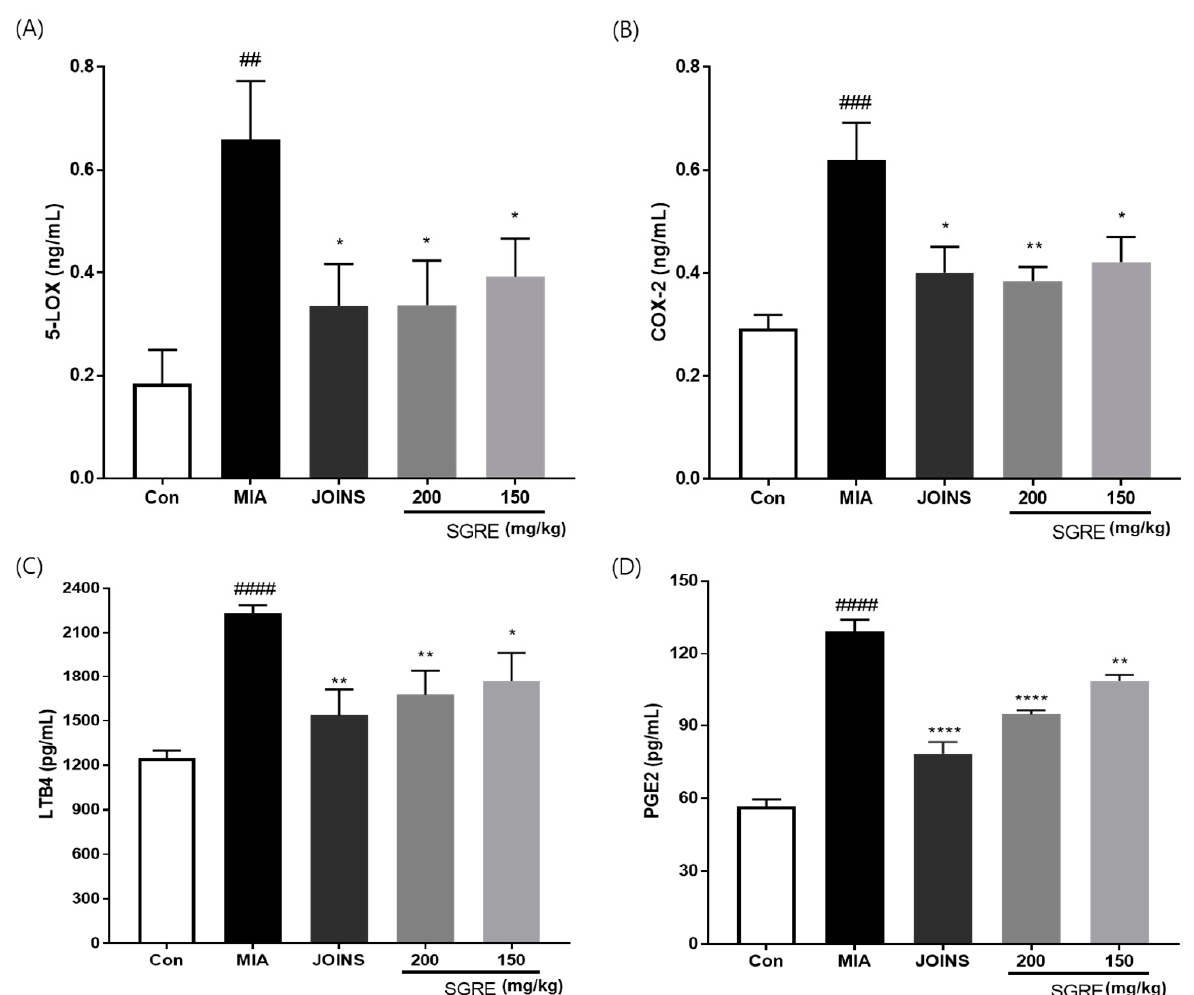
Figure 8. Effects of SGRE on the serum levels of inflammatory mediators in rats with MIA-induced OA. ( A ) Serum 5-LOX, ( B ) COX-2, ( C ) LTB4, and ( D ) PGE2 levels. n = 7 per group. ## p < 0.01; ### p < 0.001; #### p < 0.0001 vs. control group. * p < 0.05, ** p < 0.01; **** p < 0.0001 vs. MIA-induced group.